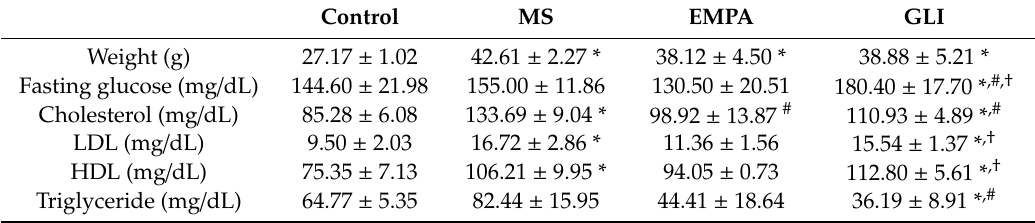
Table 1. Characteristics of the study groups at the time of collecting adipose tissues.